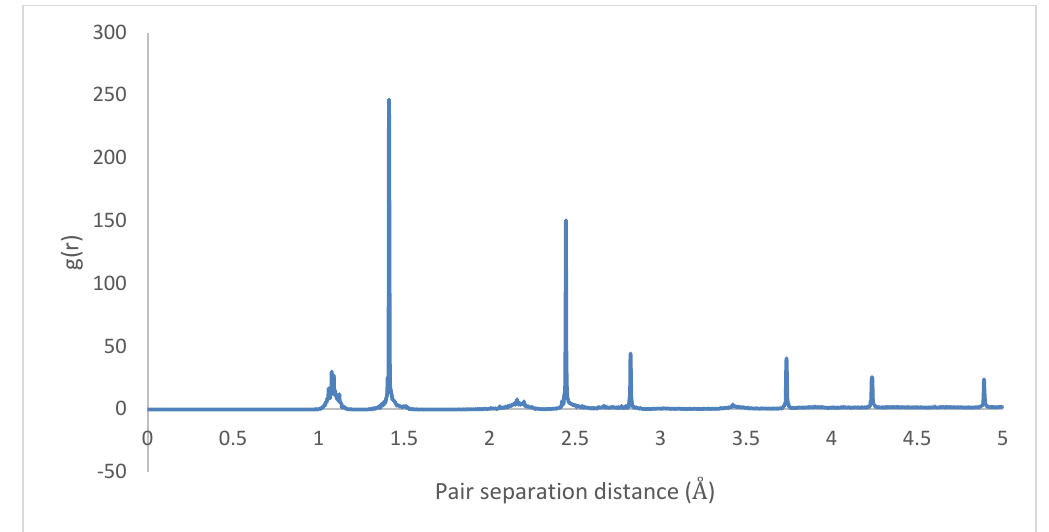
Figure 30. Radial distribution function (RDF) 4PPV with CNT (final).